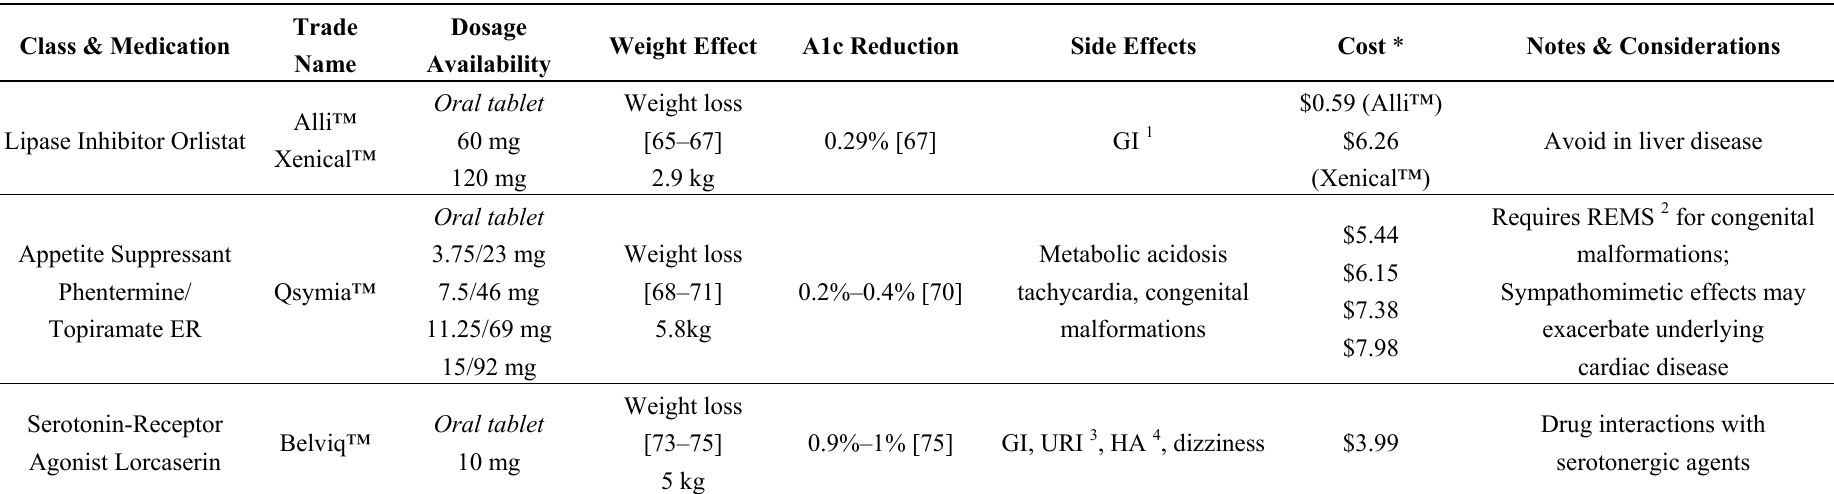
Table 2. Effect of anti-obesity agents on glucose